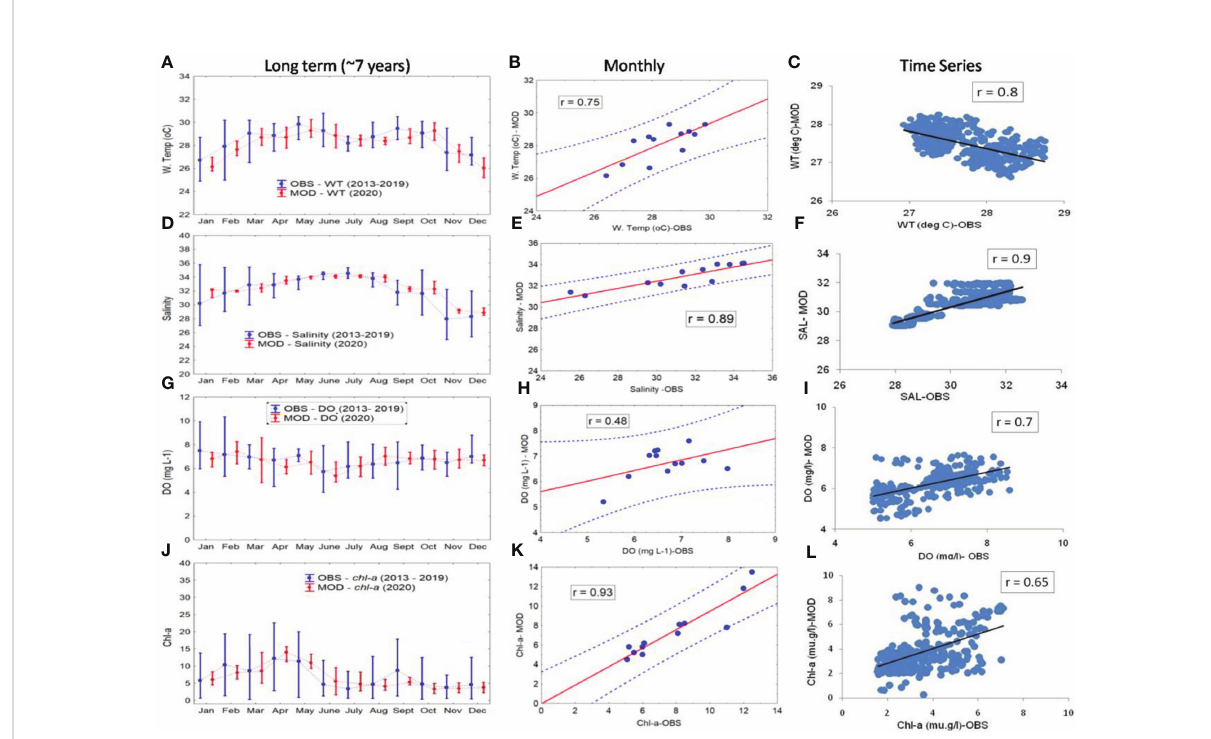
FIGURE 2 Validation of water temperature: (A) long term, (B) monthly, and (C) time series. Salinity: (D) long term, (E) monthly, and (F) time series. Dissolved oxygen: (G) long term, (H) monthly, and (I) time series. Chl- a : (J) long term, (K) monthly, and (L) time